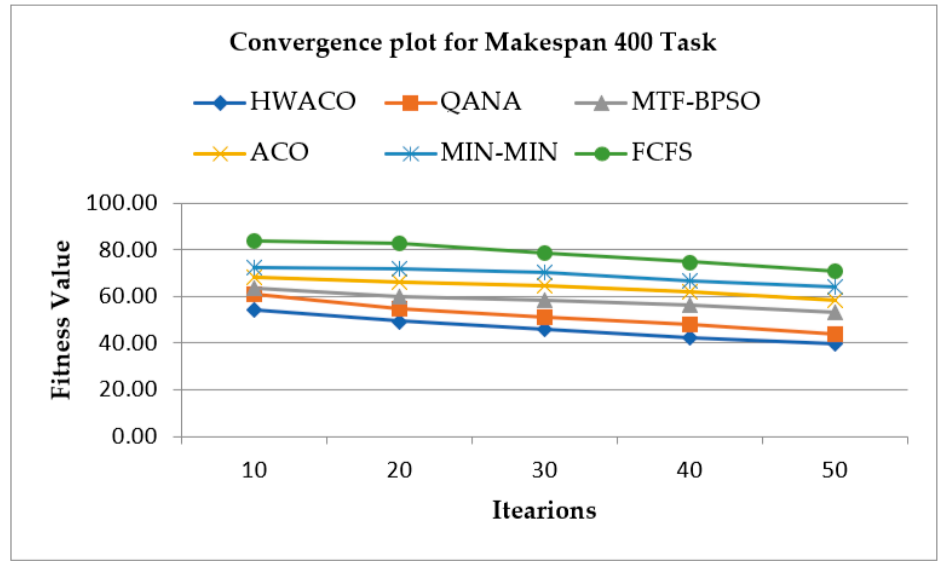
Figure 5. The convergence plot for makespan of 400 tasks.